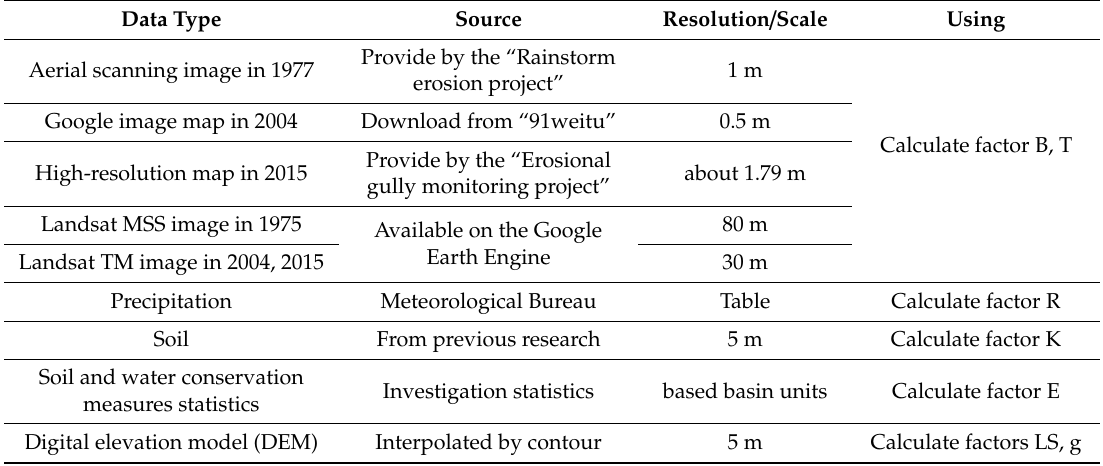
Table 1. Data preparation in this study.